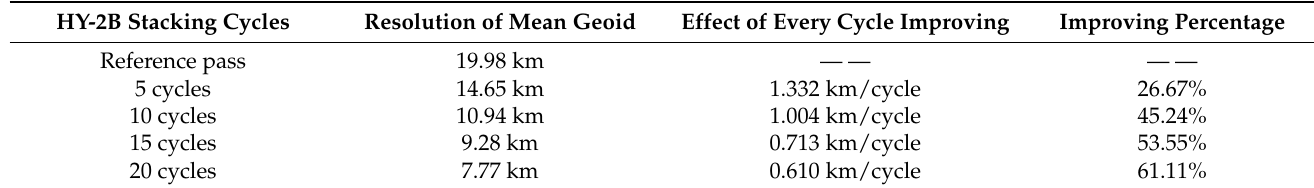
Table 5. The average resolution capabilities and improvement effect of HY-2B stacking data.